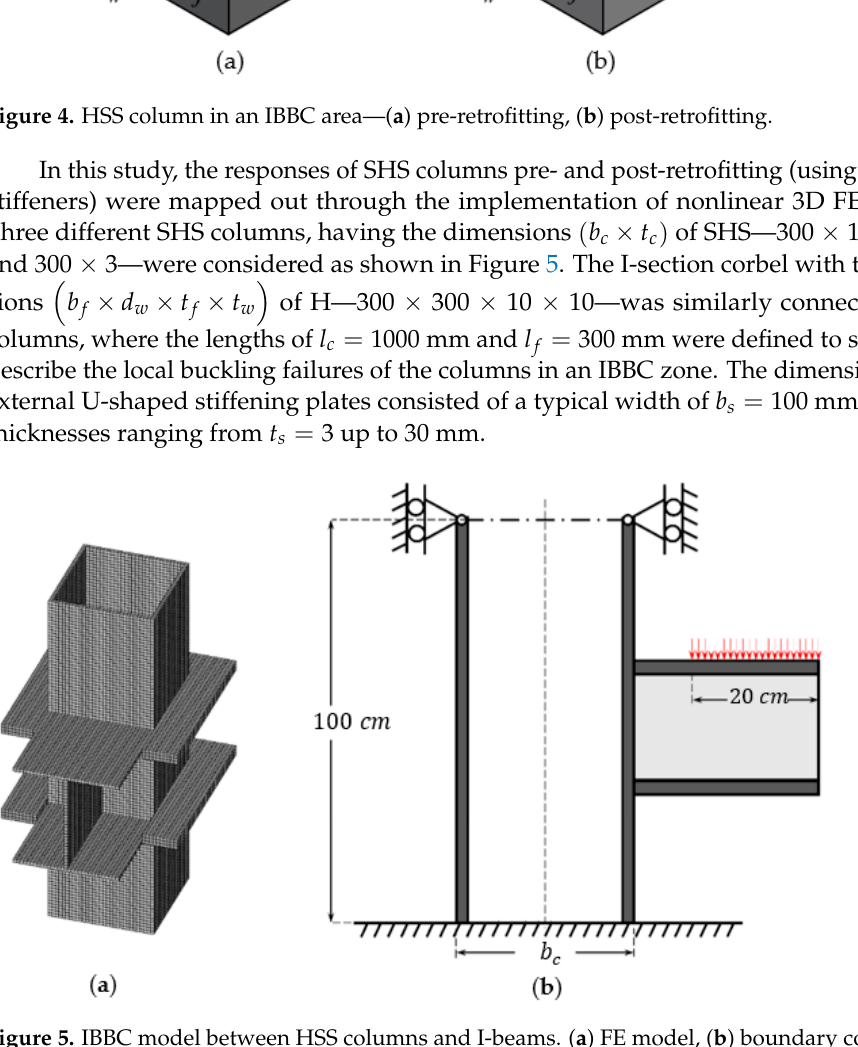
Figure 5. IBBC model between HSS columns and I-beams. ( a ) FE model, ( b ) boundary